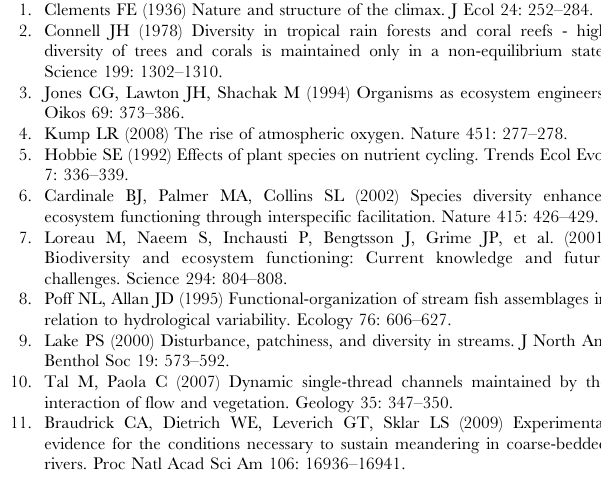
Figure S3 Prior to the experiment, we calibrated motor dial position to near-bed shear stress using velocity profiles. These measurements were taken before the experiment because it was not possible to measure velocity during the experiment itself when the caddisflies and their nets were present. We measured velocity profiles above the center of the working rock patch using an arrangement of surface rocks cemented to plexiglass at a height and location identical to rocks in the experiment. (A) Examples of velocity profiles for two motor dial positions. To estimate shear stress from the velocity profiles, we used standard methods to find the slope of the linear regression of velocity on the log of depth in the measured profile (see Methods). (B) Shear stress was calculated for motor dial positions 20, 30, 40, and 50, and linear regression was used to estimate the relationship between motor dial position and shear stress. Dial speed positions documented in the experiment were converted to shear stress values using the equation shown in the bottom right of panel B.